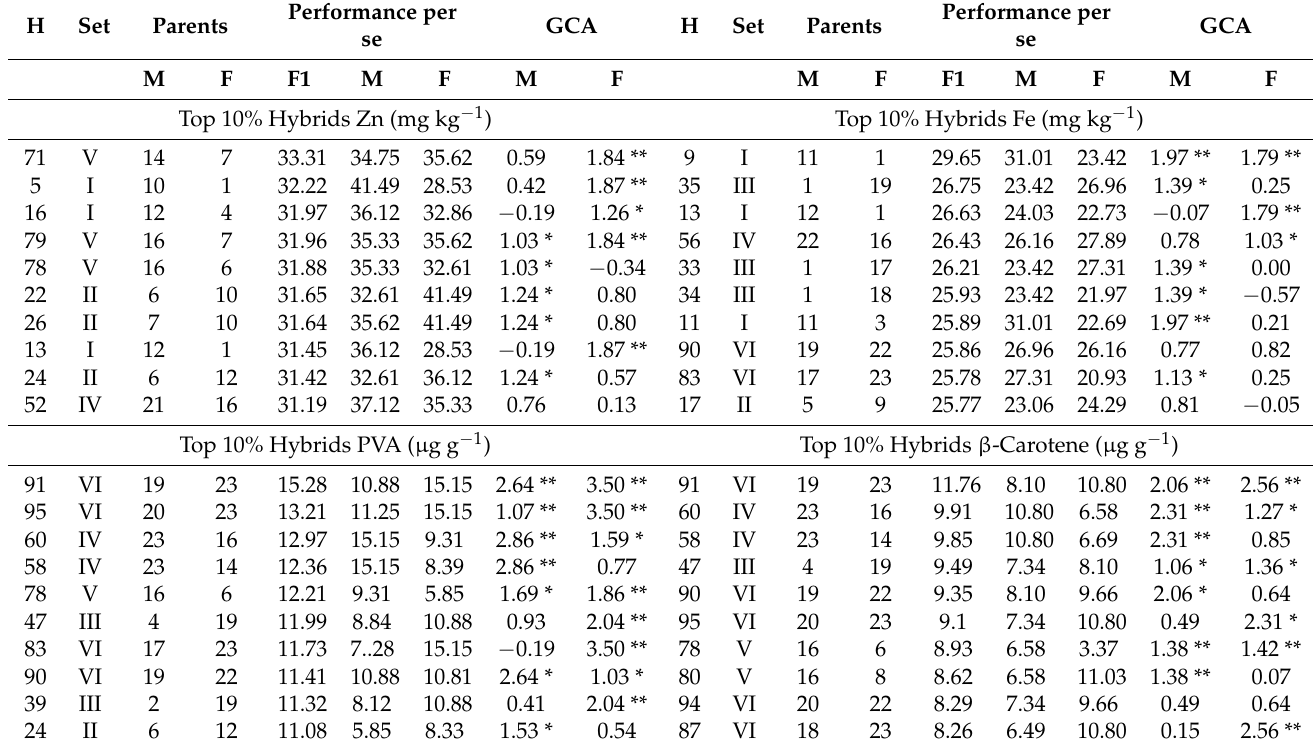
Table 5. Performance per se of hybrids and parental lines, GCA of parents for the top 10% ranking hybrids for micronutrients evaluated across environments.